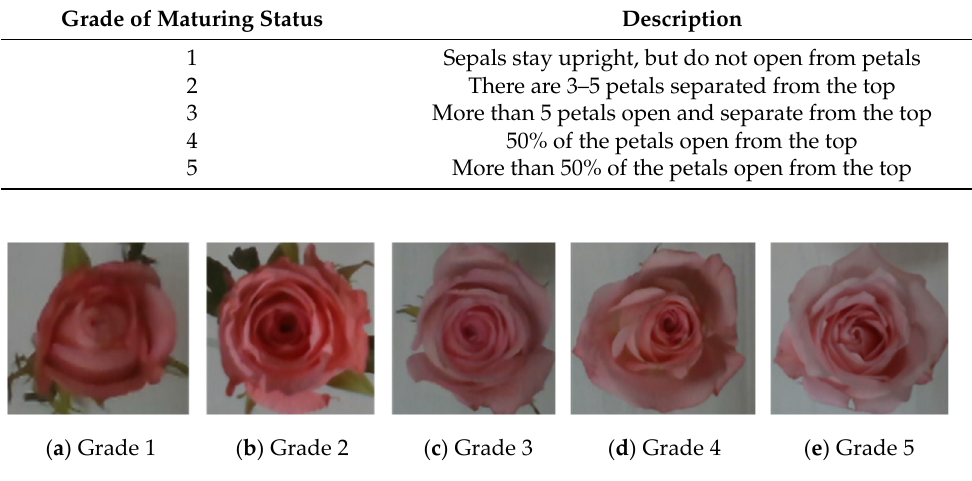
Table 1. Maturing status coding standard.